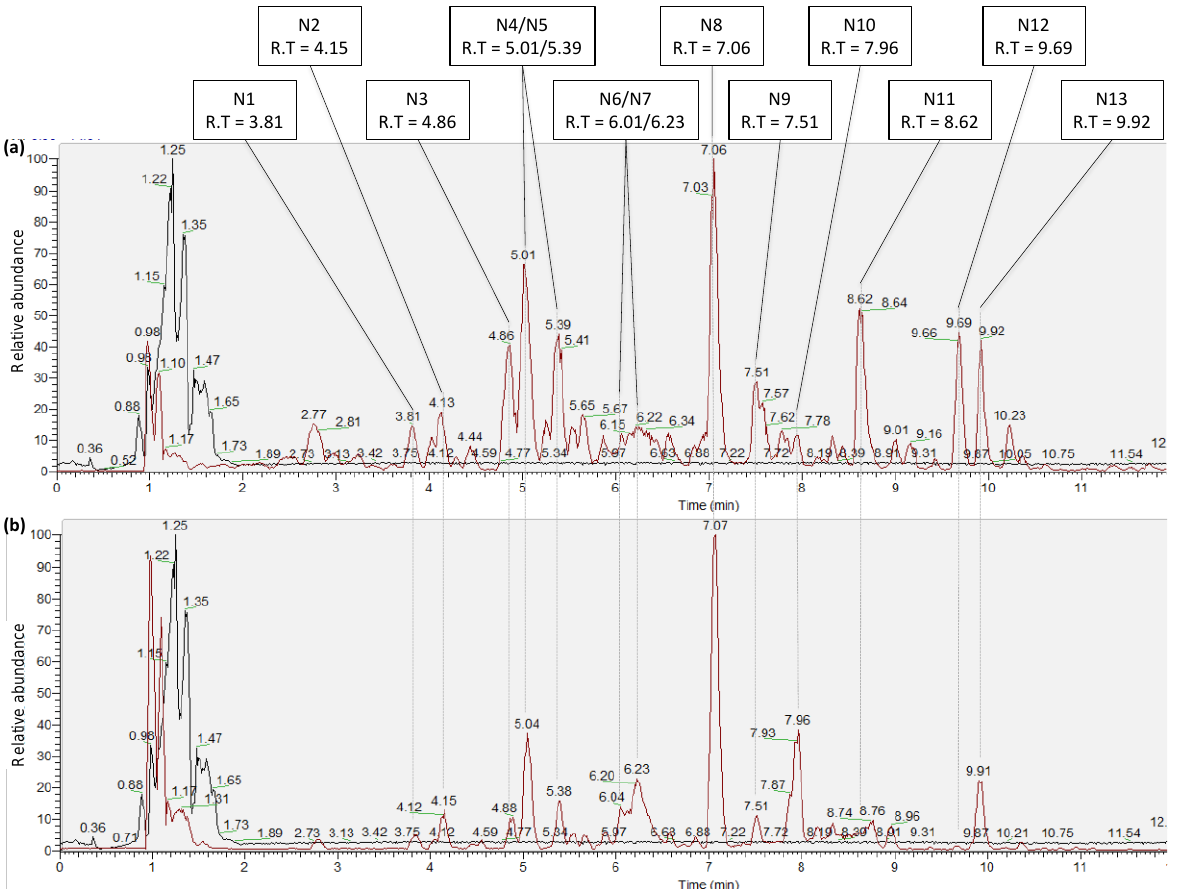
Figure 1. Negative ionisation mode chromatogram of SOA generated from the ozonolysis of α -phellandrene in (a) a standard experiment (no. 10) and (b) an experiment that had formic acid added as a stabilised CI scavenger (no. 6). The red line represents the sample, whilst the black line is a preconditioned blank filter. Major negative mode ionisation peaks detected across all experiments (Table 2) are labelled.